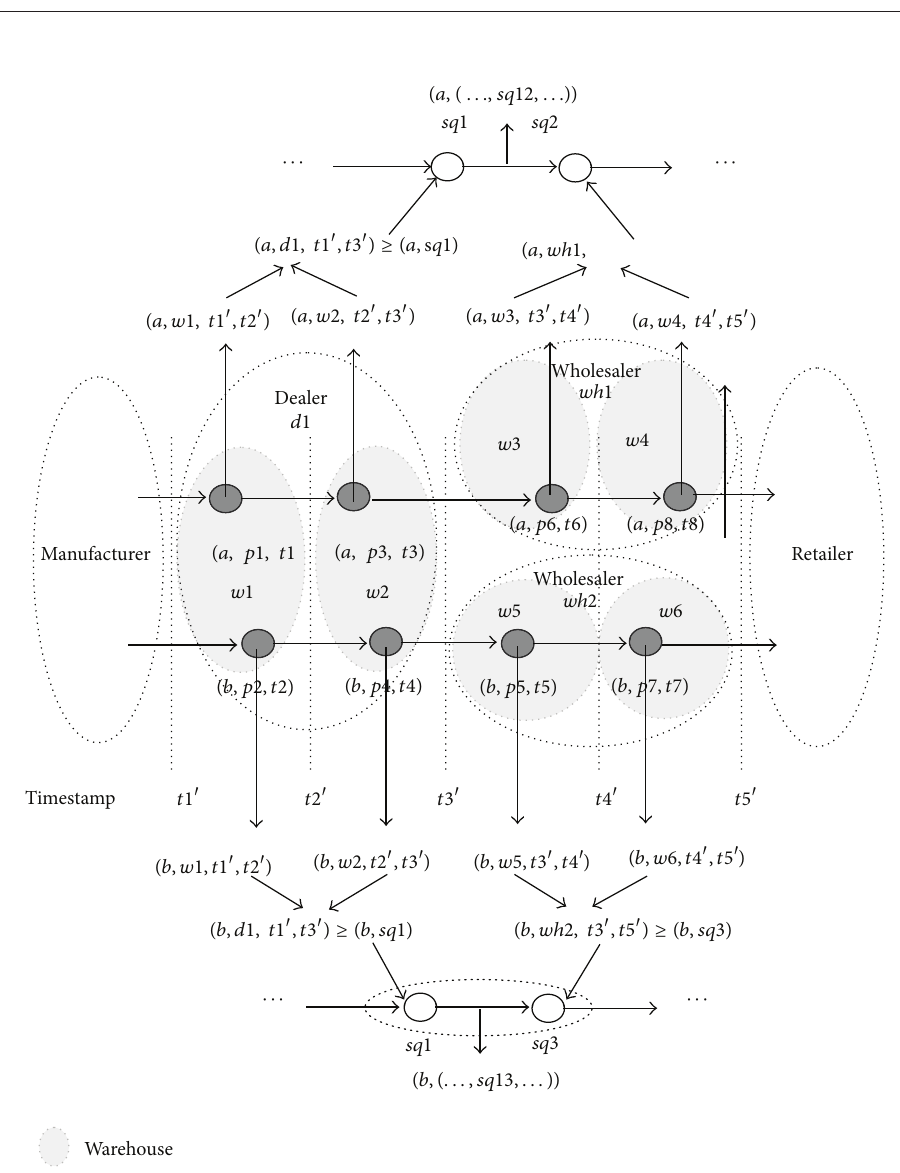
Figure 8: Aggregations for RFID